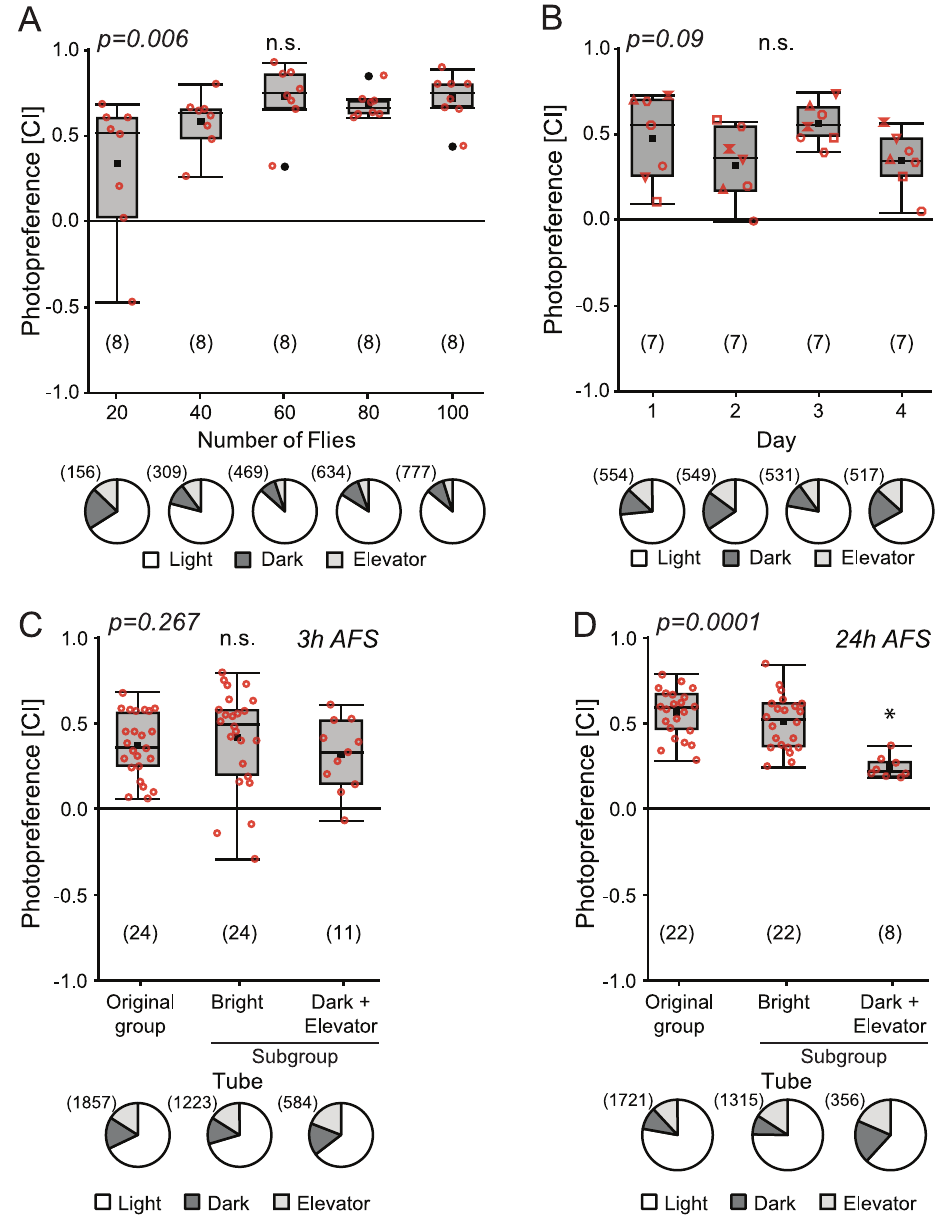
Fig 2. Photopreference results are independent of prior testing. (A) Groups of 20, 40, 60, 80 or 100 flies were tested for their photopreference in a light/dark T-maze. Upper: Box plots depicting photopreference distributions. Lower: Pie charts illustrate the distribution of all tested flies in each compartment of the T-Maze (B) Groups of 80 flies tested for photopreference on consecutive days. (C and D) Photopreference of subgroups generated after the first photopreference session (AFS). (C) 3h After the first test. (D) 24h after the first test. Box plots denote quantiles 0.05, 0.25, 0.75 and 0.95, median, mean (black square), and outliers (black dots). Individual data points are shown in red circles. Same shapes in B represent individual data points from different experiments over time. � p < 0.005. n.s: not significant. Numbers in brackets represent sample